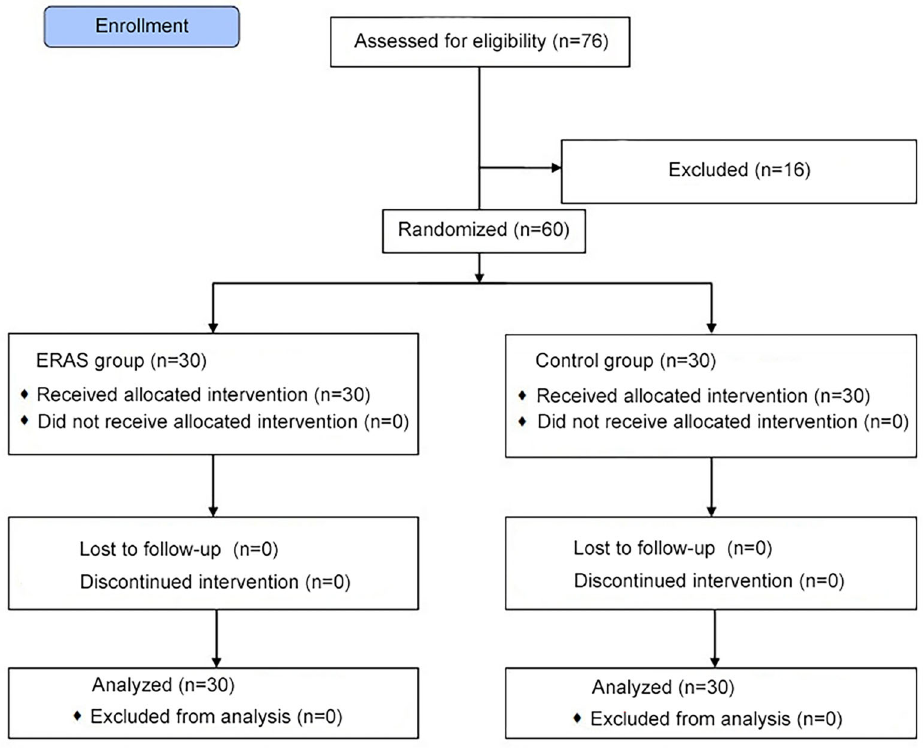
Figure 1. Flow diagram of patient selection and